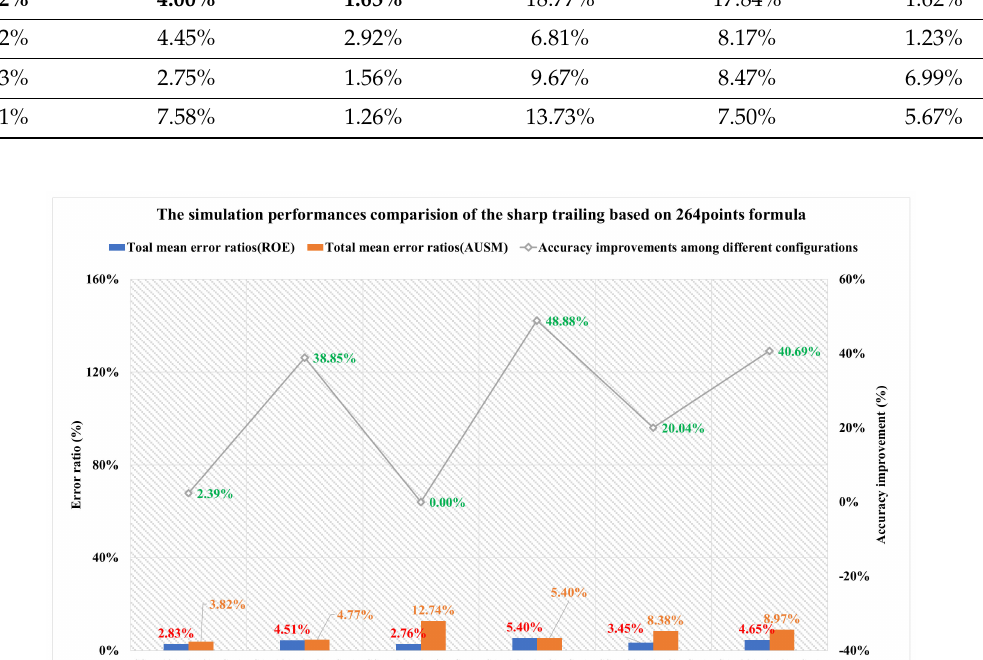
Figure 16. Comparison of the simulation performances of the sharp trailing edge based on 264 points formula under different simulation